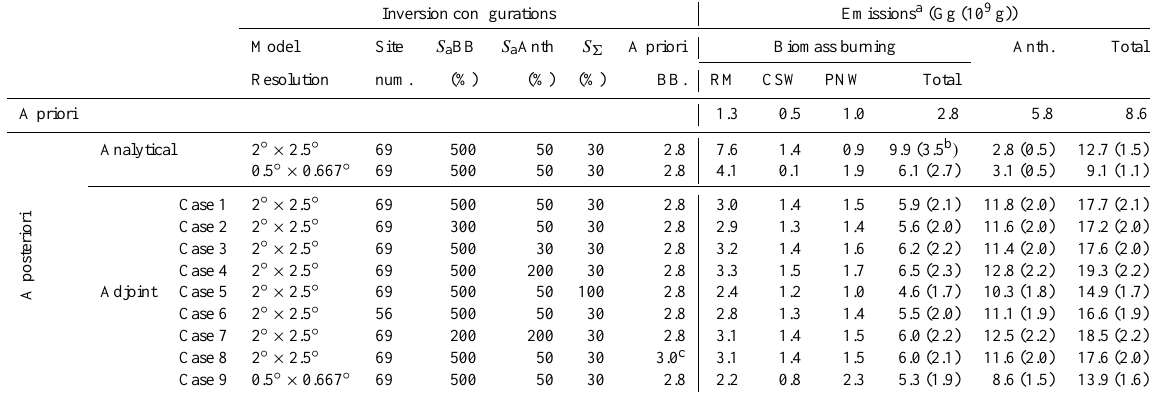
Table 1. Monthly biomass burning and anthropogenic emissions of BC (unit: Gg) in the WUS for August 2006. Inversion configurations